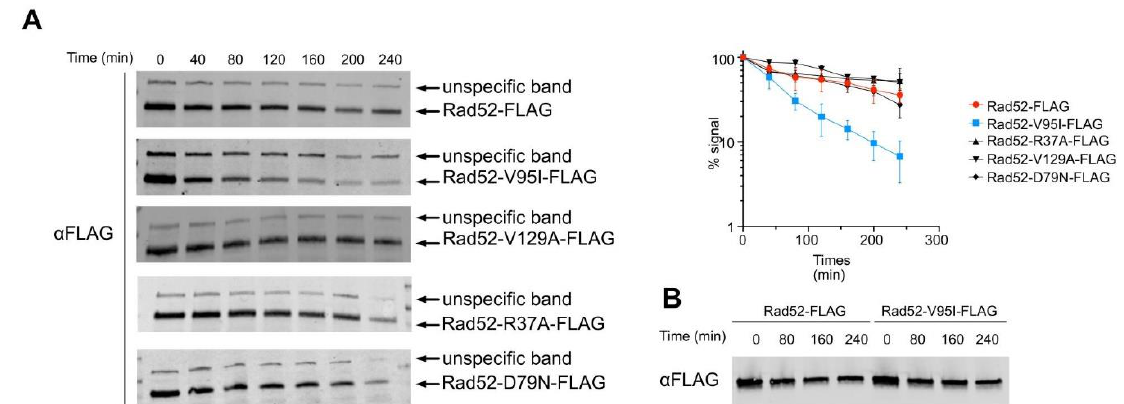
Figure 4. Protein decay of wild-type Rad52 and N-terminal Rad52 mutants. ( A ) Cycloheximide expression shut-off experiments were performed to measure the stability of Rad52-FLAG, Rad52-V95I-FLAG, Rad52V129A-FLAG, Rad52-R37A-FLAG and Rad52-D79N-FLAG. For each time point, the proteins from whole cell extracts were separated by SDS-PAGE and immunoblotted with mouse anti-FLAG monoclonal antibody. The average quantification of at least 3 experiments is shown. ( B ) In vitro stability of Rad52-FLAG and Rad52-V95I-FLAG.